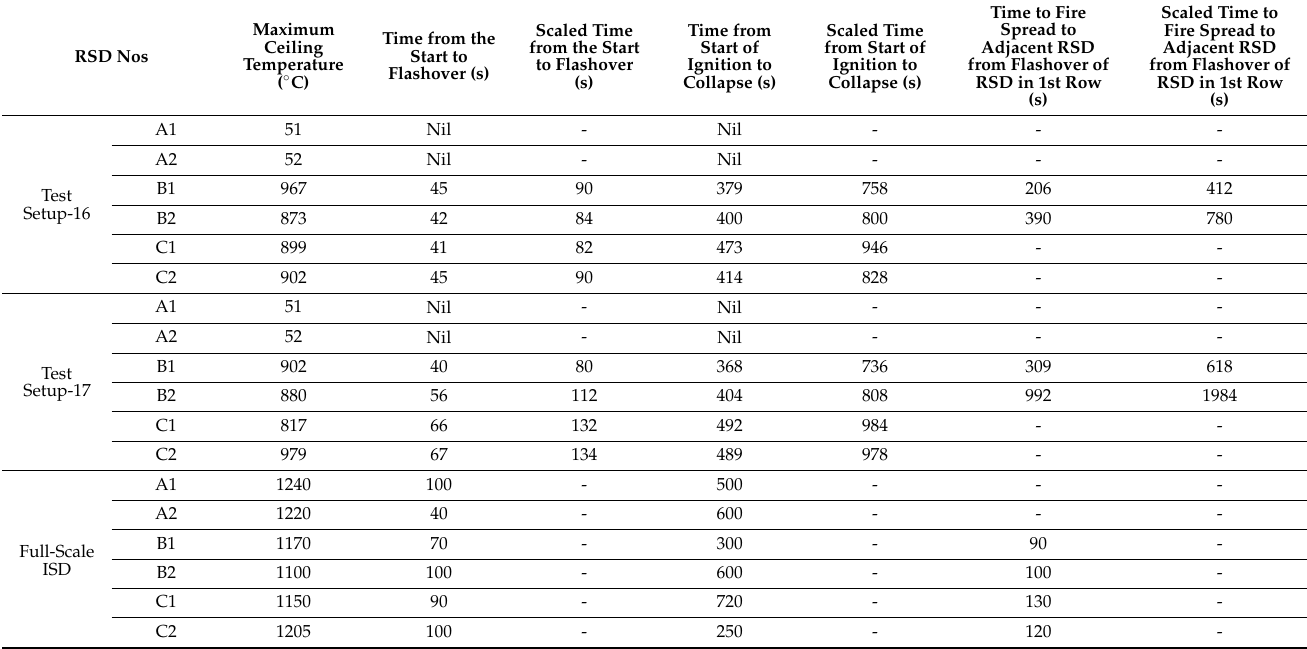
Table 11. Comparative results of test-16 and 17 with FSE.